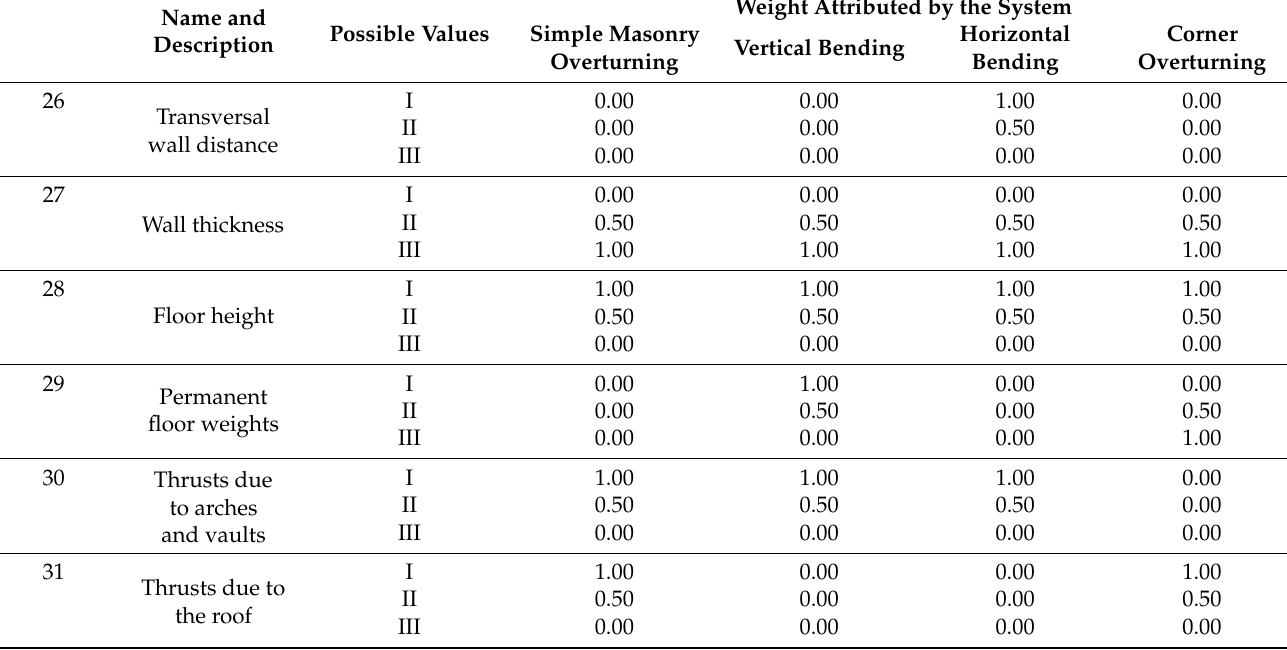
Table A5. Building characteristics